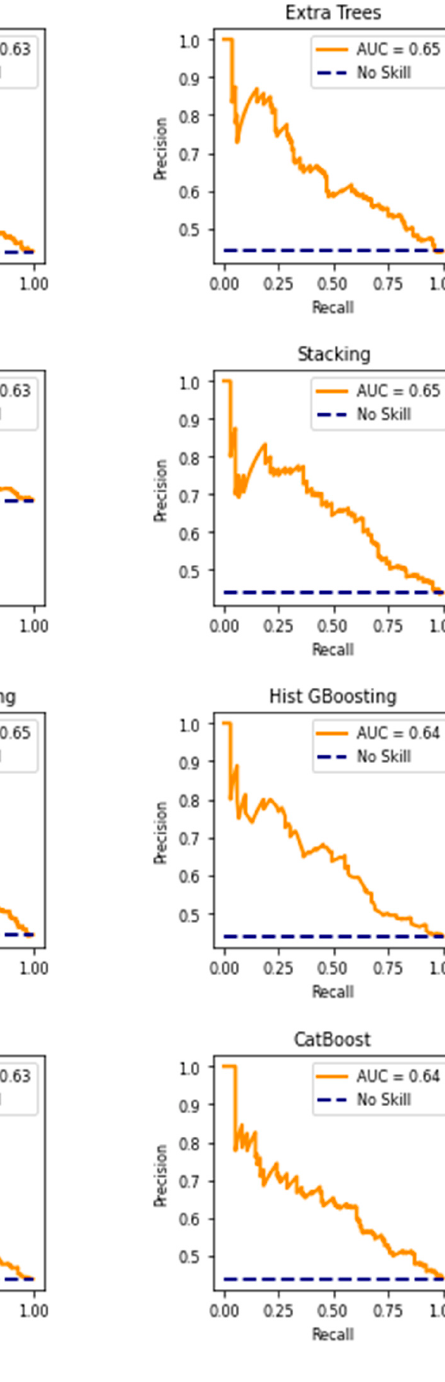
Figure A2. Precision–recall curve.